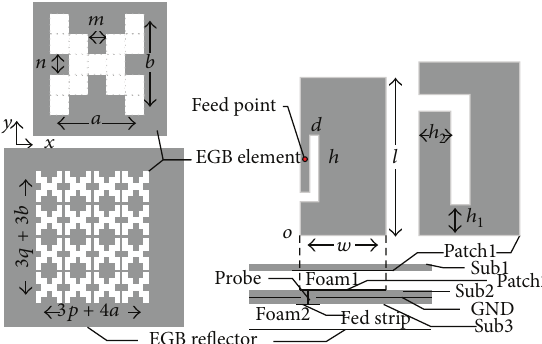
Figure 1: Element antenna structure.